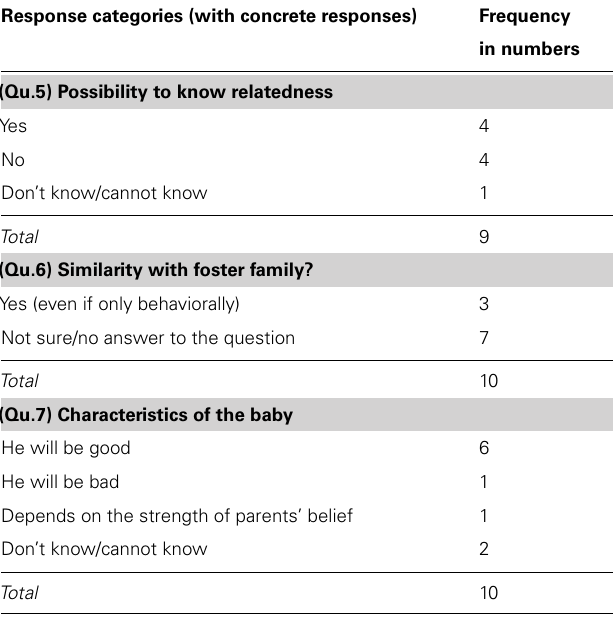
Table 4 | Responses on essentialist notions of persons and their relations (cluster